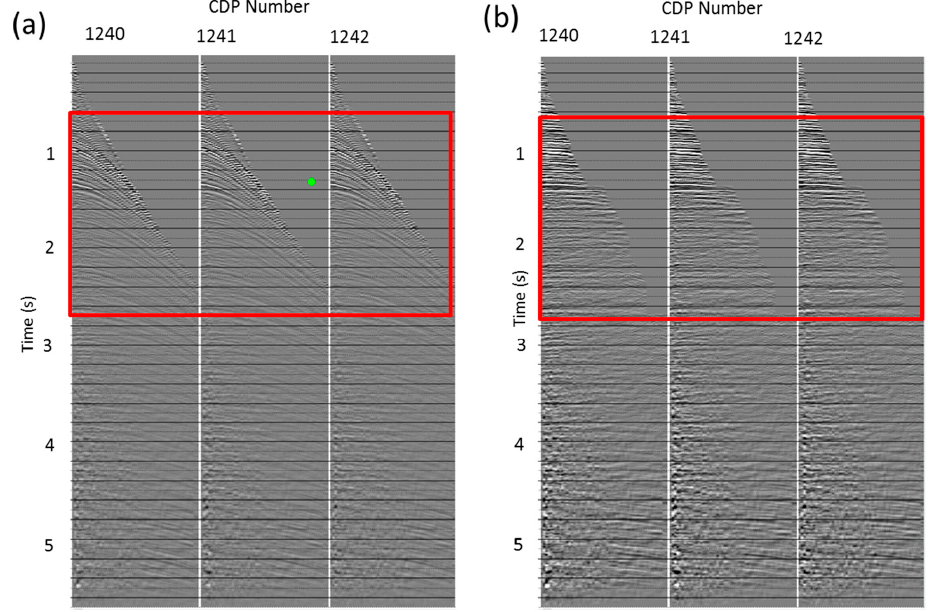
Figure 7. ( a ) Before normal moveout (NMO) correction, and ( b ) after NMO correction. The gathers are flattened with the accurate velocity.